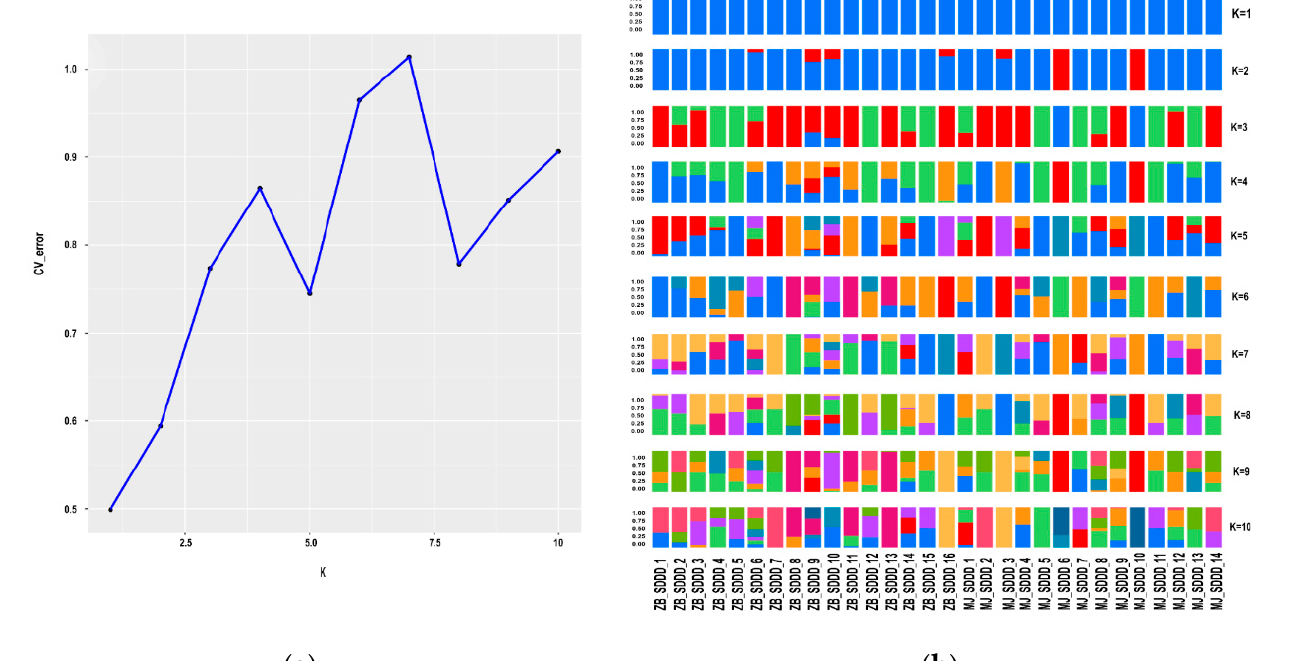
Figure 5. The group structure diagrams. ( a ) The cross-validation error for L. kasmira according to the admixture value K; ( b ) results of Bayesian cluster analysis of L. kasmira based on SNP loci using ADMIXTURE software for K = 1–10 clusters.